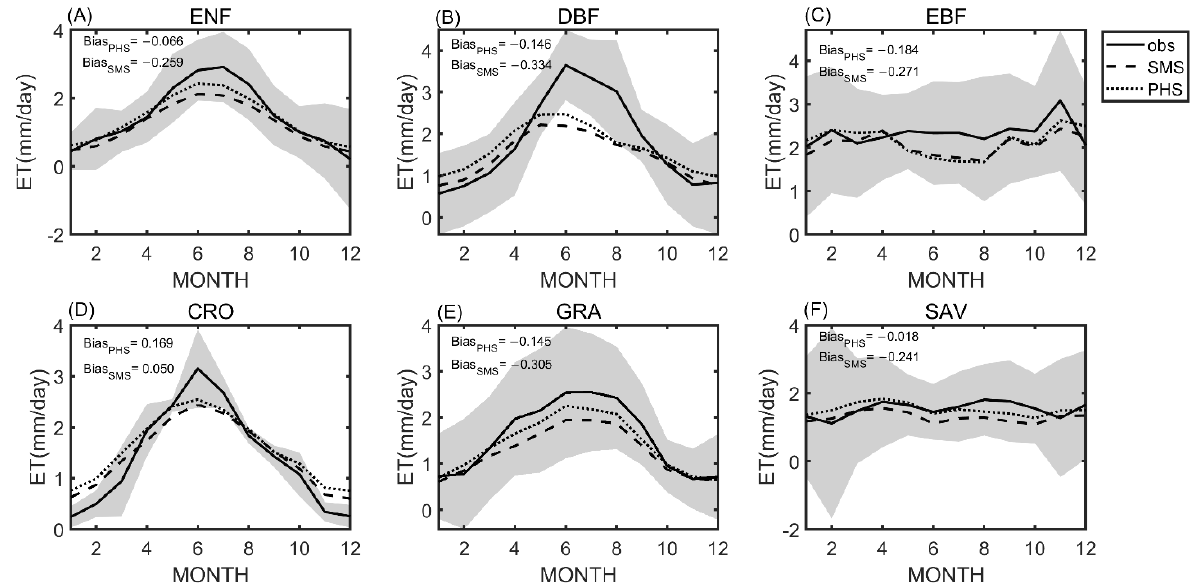
Figure 2. Seasonal variation in evapotranspiration. The climatologic mean in evapotranspiration is the average over all site-year seasonal variations, which is grouped into six plant types (( A ), evergreen needleleaf forest; ( B ), deciduous broadleaf forest; ( C ), evergreen broadleaf forest; ( D ), cropland; ( E ), grassland; ( F ), savanna). The shadow is the standard deviation of the observation. The Bias PHS is the annual mean difference in evapotranspiration between observation and plant hydraulic schemes (PHS), and Bias SMS is the annual mean difference in evapotranspiration between observation and soil moisture stress (SMS).